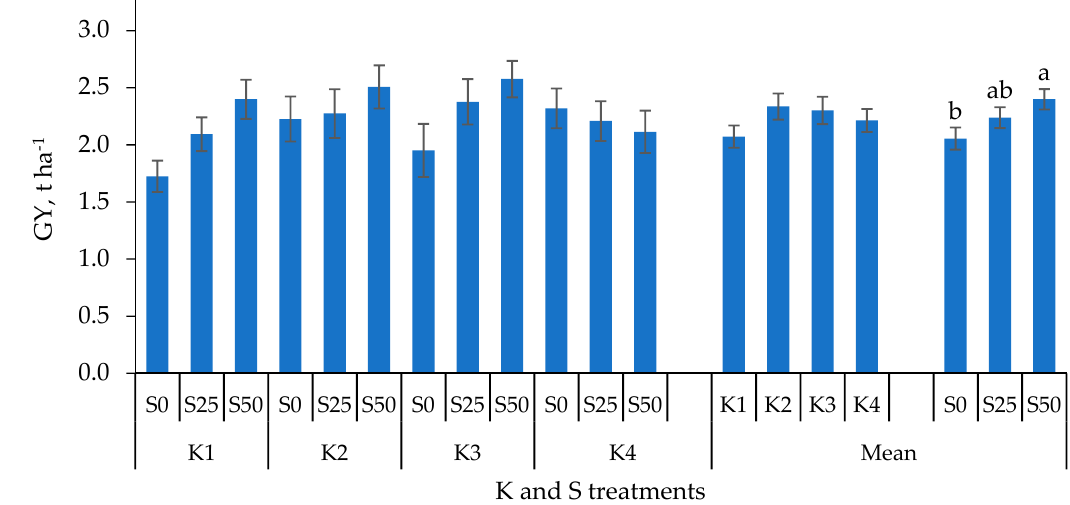
Figure 1. Effect of K treatments and S application on grain yield (GY) of faba bean. K1, K2, K3, and K4 refer to levels of soil K availability and fertilization; S0, S25, and S50 refer to sulfur application at rates of 0, 25, and 50 kg S ha − 1 , respectively. Means followed by the same letter are not statistically different ( p < 0.05). Hatched bars represent 2 × standard error (SE) ranges.